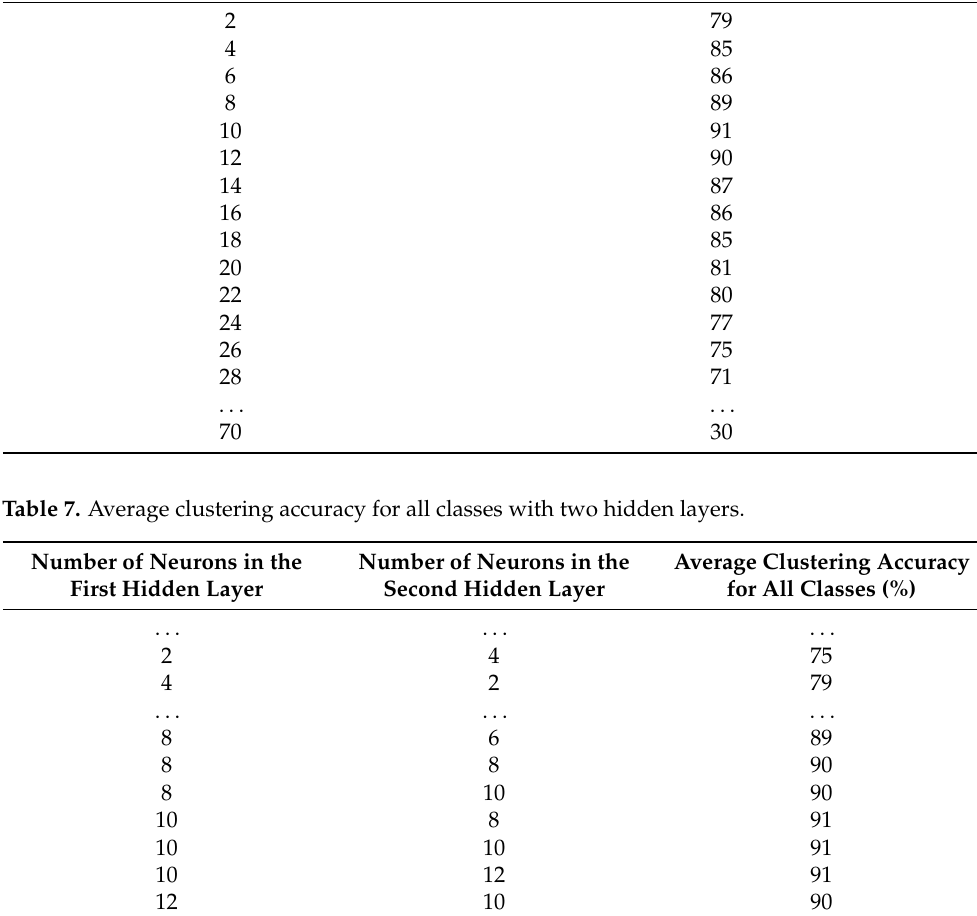
Table 6. Average clustering accuracy for all classes with a hidden layer. Number of Neurons in the Hidden Layer